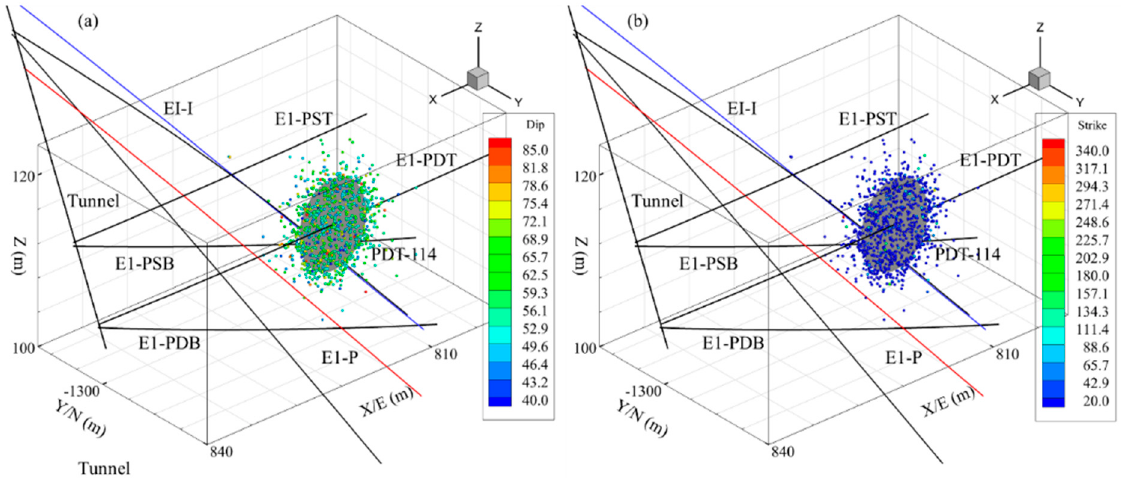
Figure 3. (a) The dip of micro-fractures within the surrounding zone of PDT-114. ( b ) the strike of micro-fractures within the surrounding zone of PDT-114.